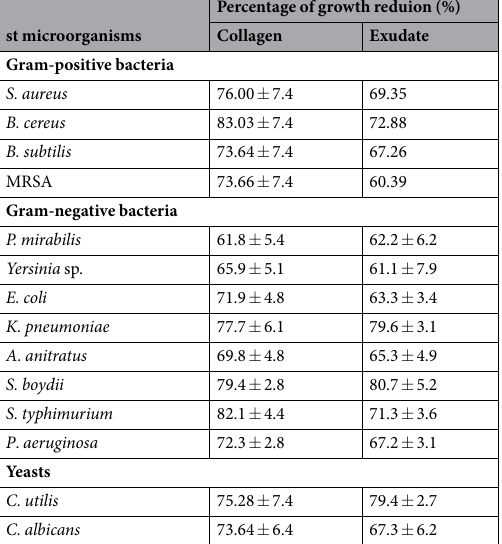
Table 5. Percentage of growth reduction exhibited by EoNP on 3D collagen wound